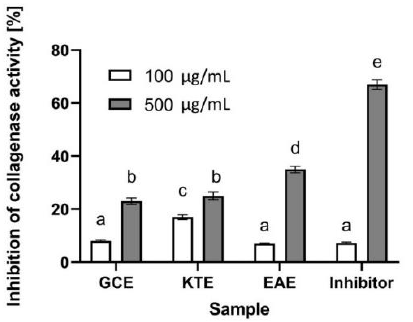
Figure 14. Influence of Centella asiatica L. (GCE), Clitoria ternatea L. (KTE) and Epilobium angustifolium L. (EAE) extracts on collagenase inhibition. Data are the mean ± SD of three independent experiments, each of which consists of three replicates per treatment group. Different letters on the charts indicate significant differences between groups ( p < 0.05).